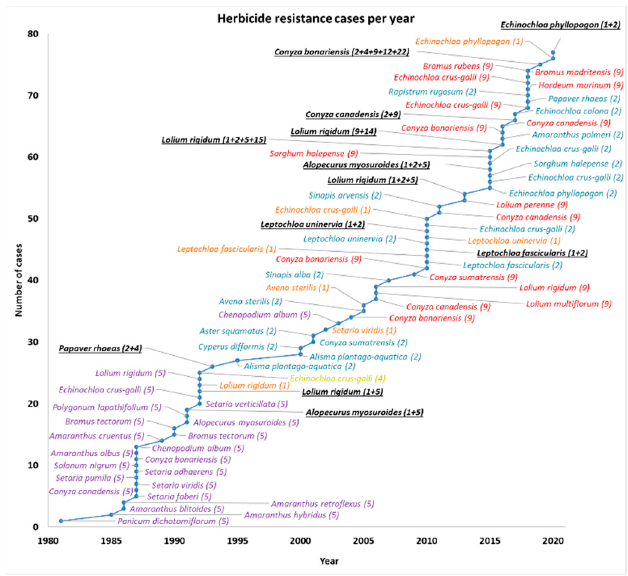
Figure 1. History of reports of herbicide-resistant weeds in the Iberian Peninsula, Spain, and Portugal. Chart was constructed based on the information available in the International Survey of Herbicide-resistant Weeds database [4], plus the additional cases reported in this review (Tables 1 and 2). Each color in each species represents one different mode of action (number in parentheses, according to new HRAC-WSSA classification); multiple-herbicide-resistant species ( ≥ two modes of action) in black color and underlined.